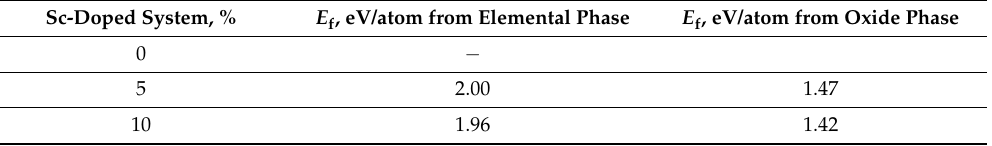
Table A1. Formation energies and corresponding bandgap of pure and Sc-doped TiO 2 .